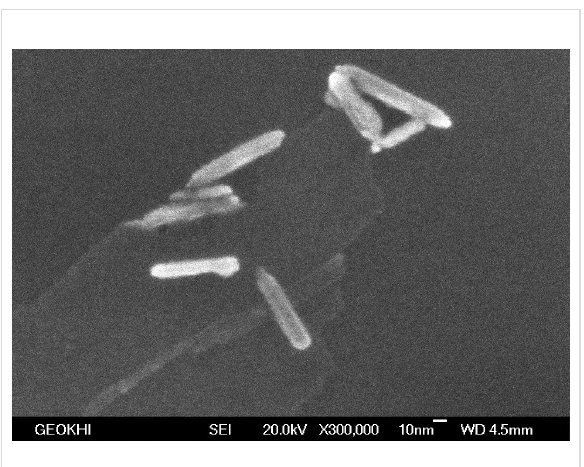
Two sets of fabric, one coated with industrial nanoparticles and the second one with nanoparticles fabricated in the sonoplasma discharge, were produced. Figure 6 shows a SEM image of the coated fabric. The sample shown was coated with commercial nanoparticles. It is clearly visible that the commercial nanoparti- cles can reach up to 1000 nm.